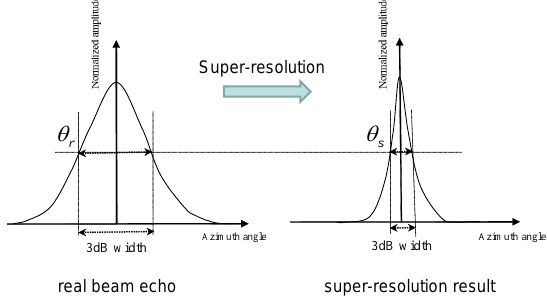
Figure 2. The definition of beam sharpening ratio (BSR).